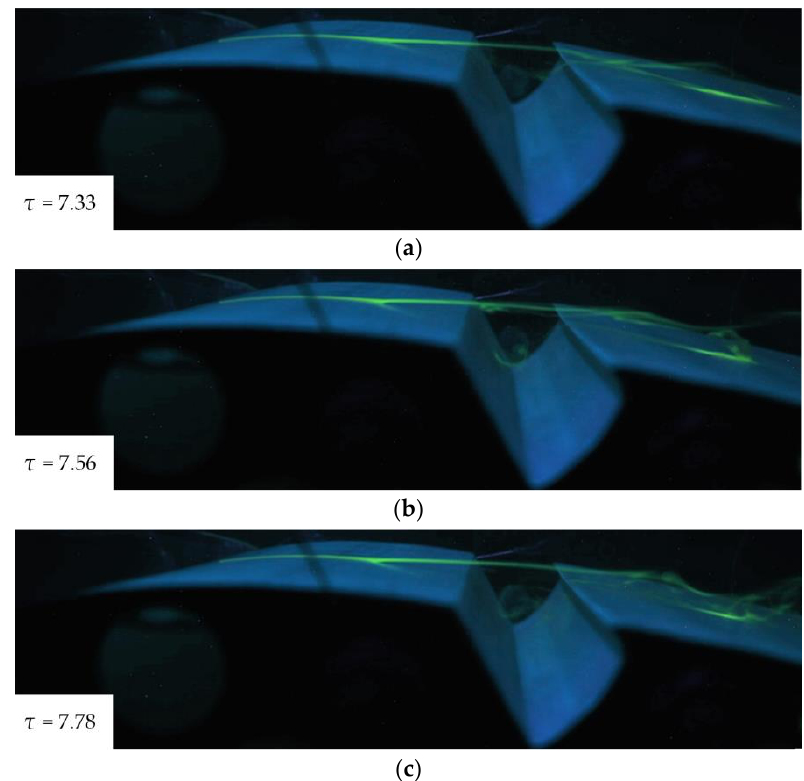
Figure 18. Flow images for cavity A at Re = 2 × 10 4 , α = 9°: ( a ) τ = 7.33; ( b ) τ = 7.56; ( c ) τ = 7.78.